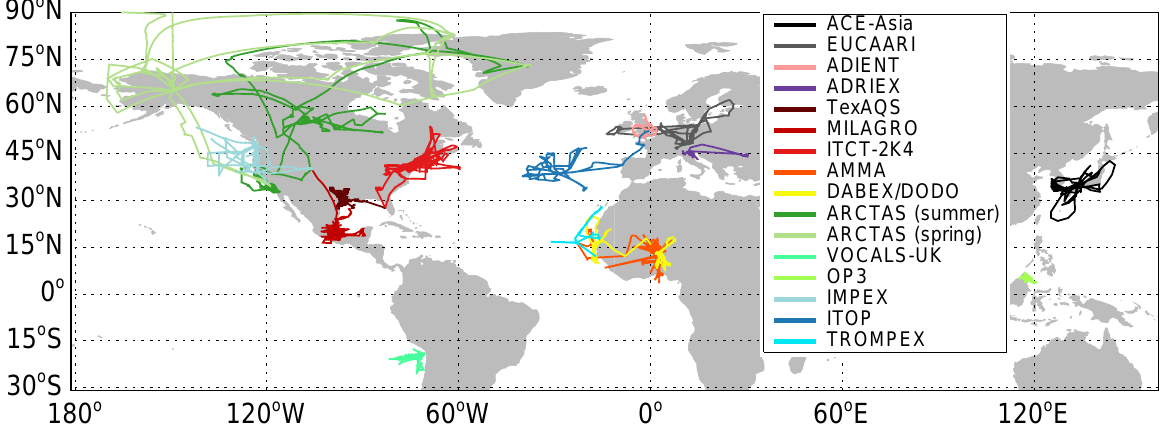
Fig. 1. Flight tracks for the 17 aircraft field campaigns examined here. See Table 1 for dates and measurement